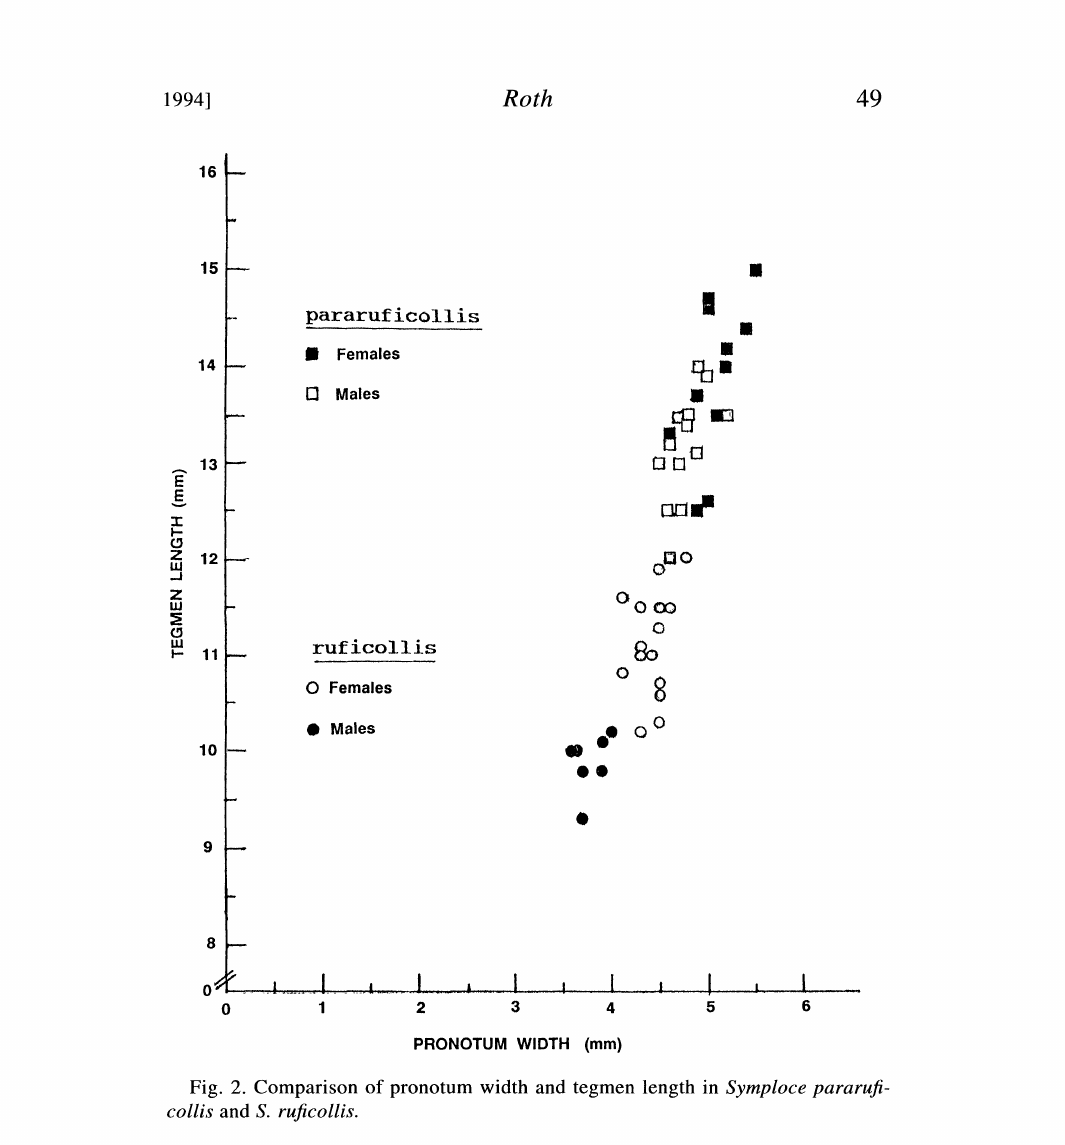
Fig. 2. Comparison of pronotum width and tegmen length in Symploce pararufi- collis and S. ruficollis. V. Becker; 299, 1-14.vii.1984, S. E. & P. M. Miller; Necker Island, 2c, 499, 24.vii.1988, Acc.#1988.350, C. O’Connell. Measurements (mm) (9 in parentheses). Length,